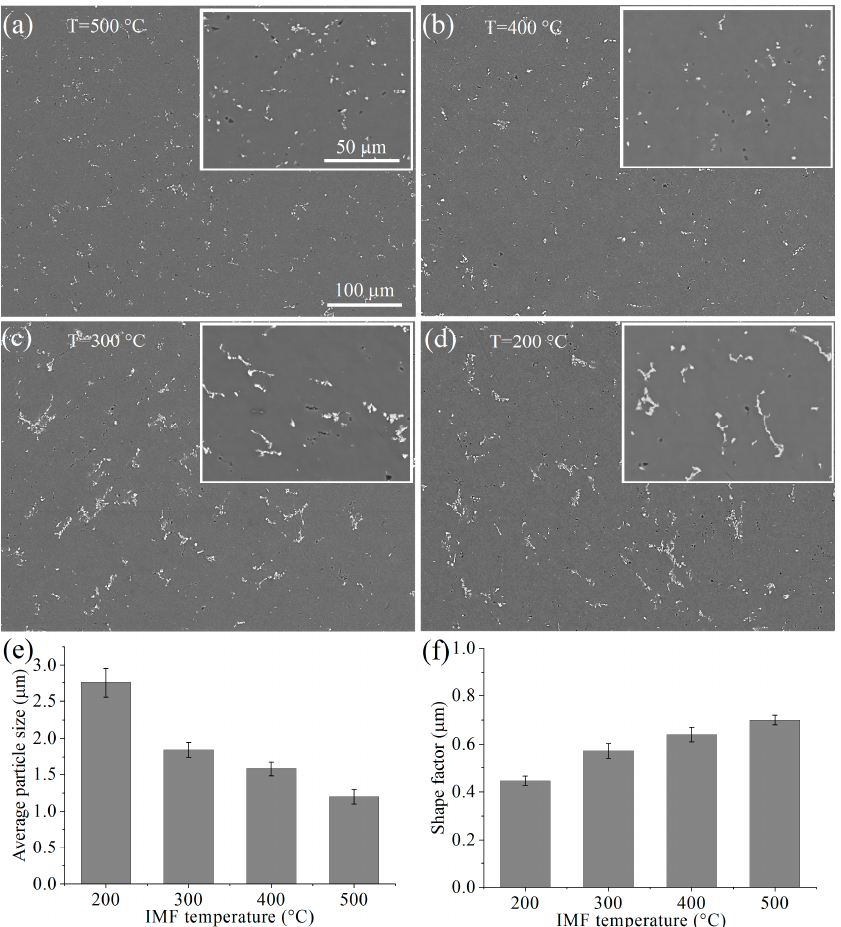
Figure 9. Microstructures of the samples after four cycles ( ∑ e = 6) IMF at ( a ) 500, ( b ) 400, ( c ) 300, and ( d ) 200 °C, and ( e ) average particle size and ( f ) shape factor dependence on IMF temperature (scanning electron microscope).